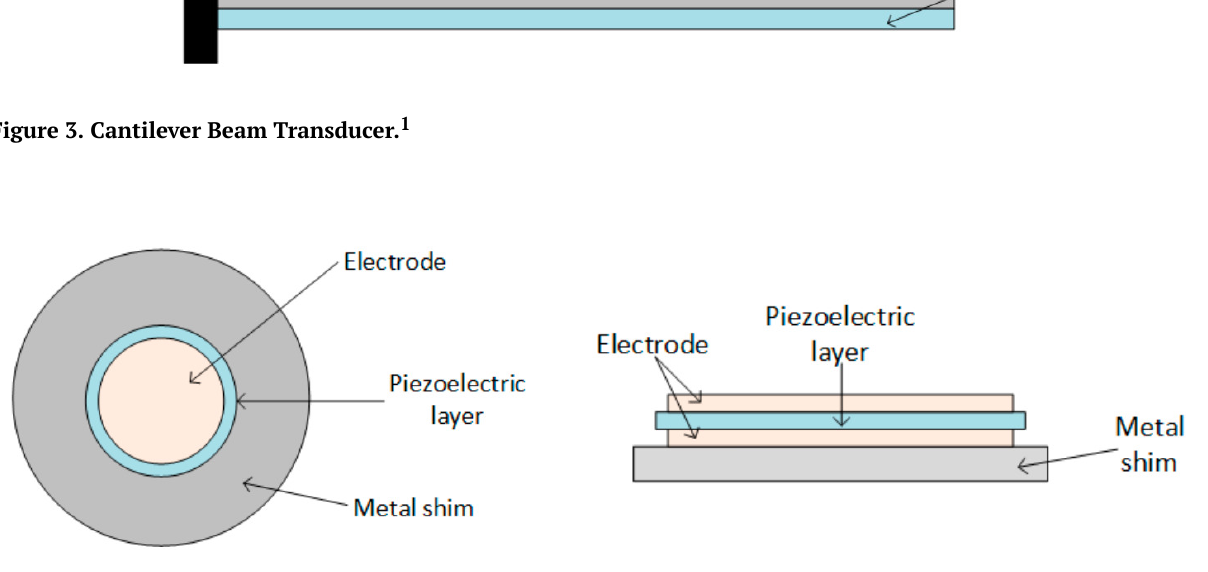
Figure 4. Circular Diaphragm Transducer. 1